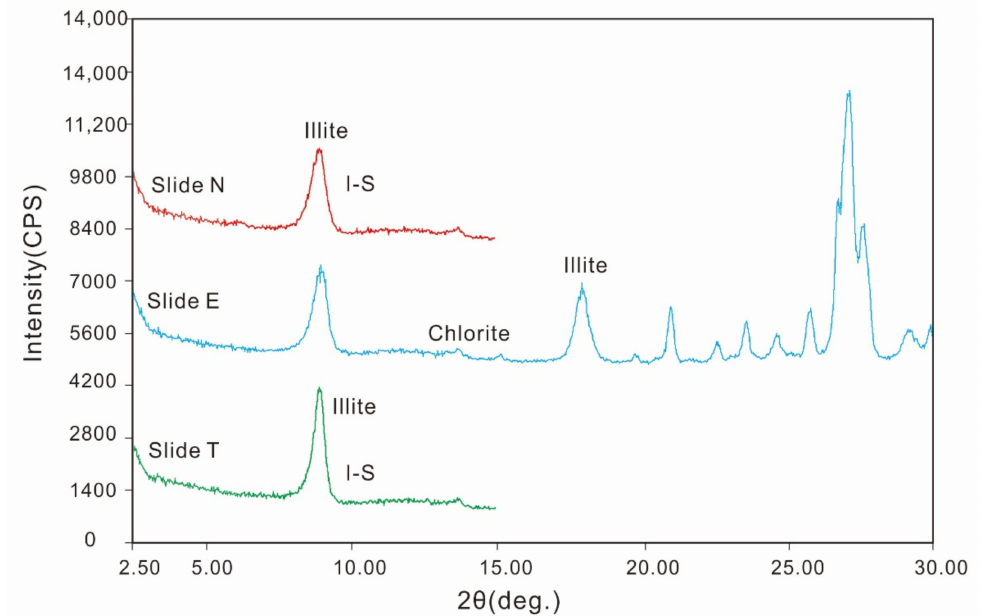
Figure 2. Clay mineral analysis of the shale samples based on XRD spectra analysis of N/E/T glass slides. Slide N is the natural sample without any treatment of the extracted clays, slide E is the sample after saturating slide N with ethylene glycol, and slide T is the sample after heating slide E under 450 ◦